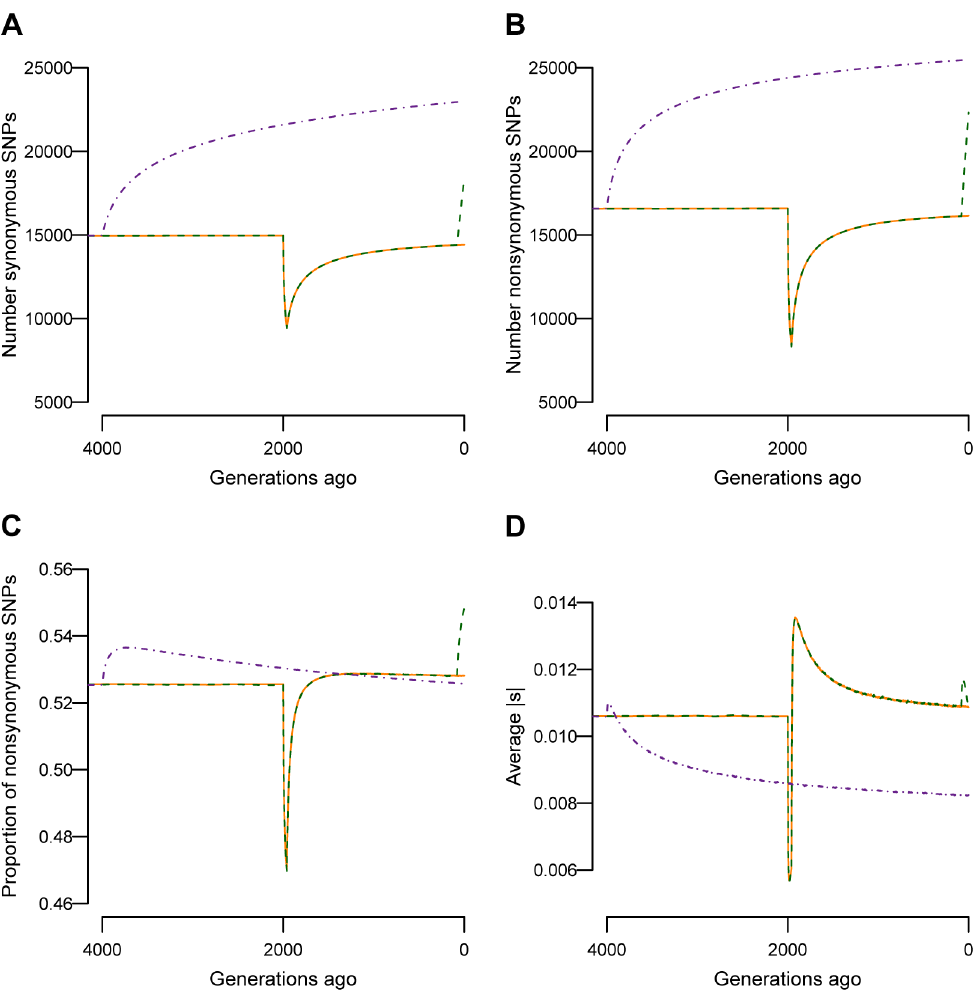
Figure 2. Changes in genetic variation over time as a function of population size. Solid orange lines denote the bottlenecked population that did not recently expand (BN). Dashed green lines denote a population that expanded 80 generations ago (BN + growth). Note that the lines from the two populations overlap except in the last 80 generations. Dashed purple lines denote the population that underwent an ancient expansion (Old growth). ( A ) Number of synonymous SNPs segregating in the sample. ( B ) Number of nonsynonymous SNPs segregating in the sample. ( C ) Proportion of SNPs segregating in the sample that are nonsynonymous. ( D ) Absolute value of the average fitness effect of nonsynonymous SNPs segregating in the sample. Samples of 1000 chromosomes were taken at different time points throughout the simulation. Results are averaged over 1000 simulation replicates.